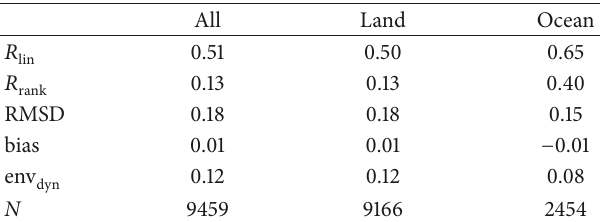
Table 4: IMARS v5.2 evaluation statistics for 2007–2015 against AERONET SDA L2.0 observations for all, land only, and ocean only IASI